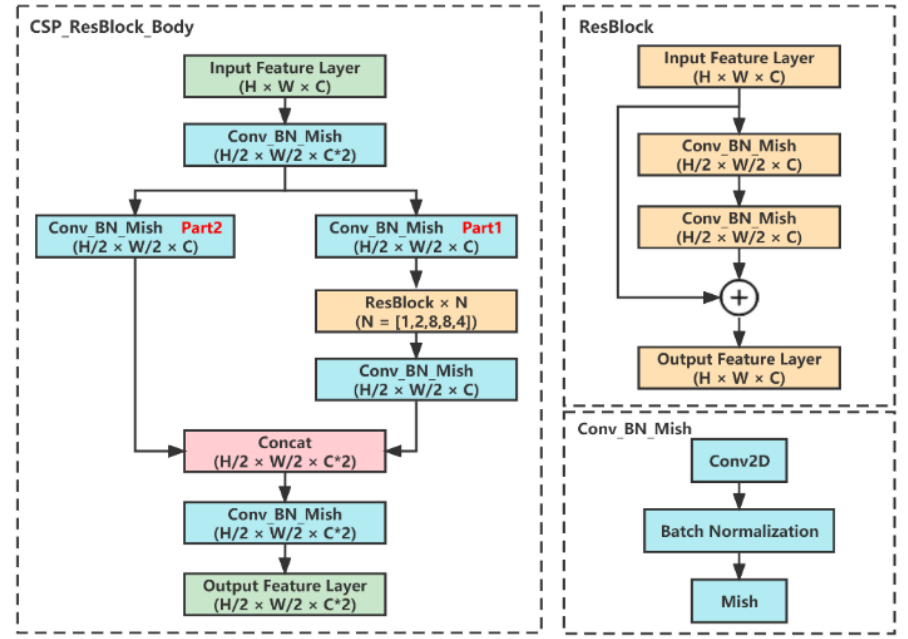
Figure 6. Structure of the CSP_ResBlock_Body module.